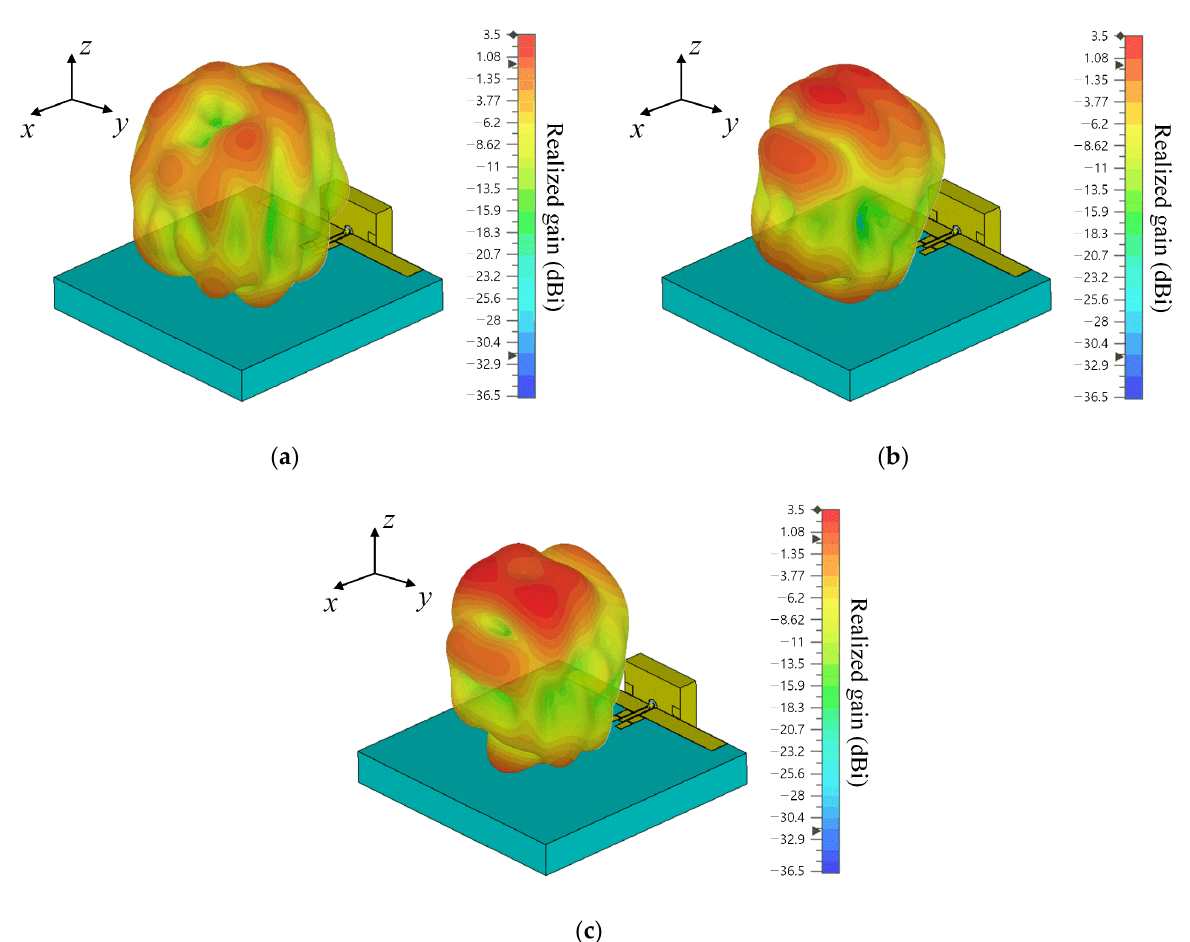
Figure 8. Three-dimensional patterns: ( a ) at 26 GHz; ( b ) at 28 GHz; ( c ) at 30 GHz. Table 2. Comparisons of antenna characteristics.